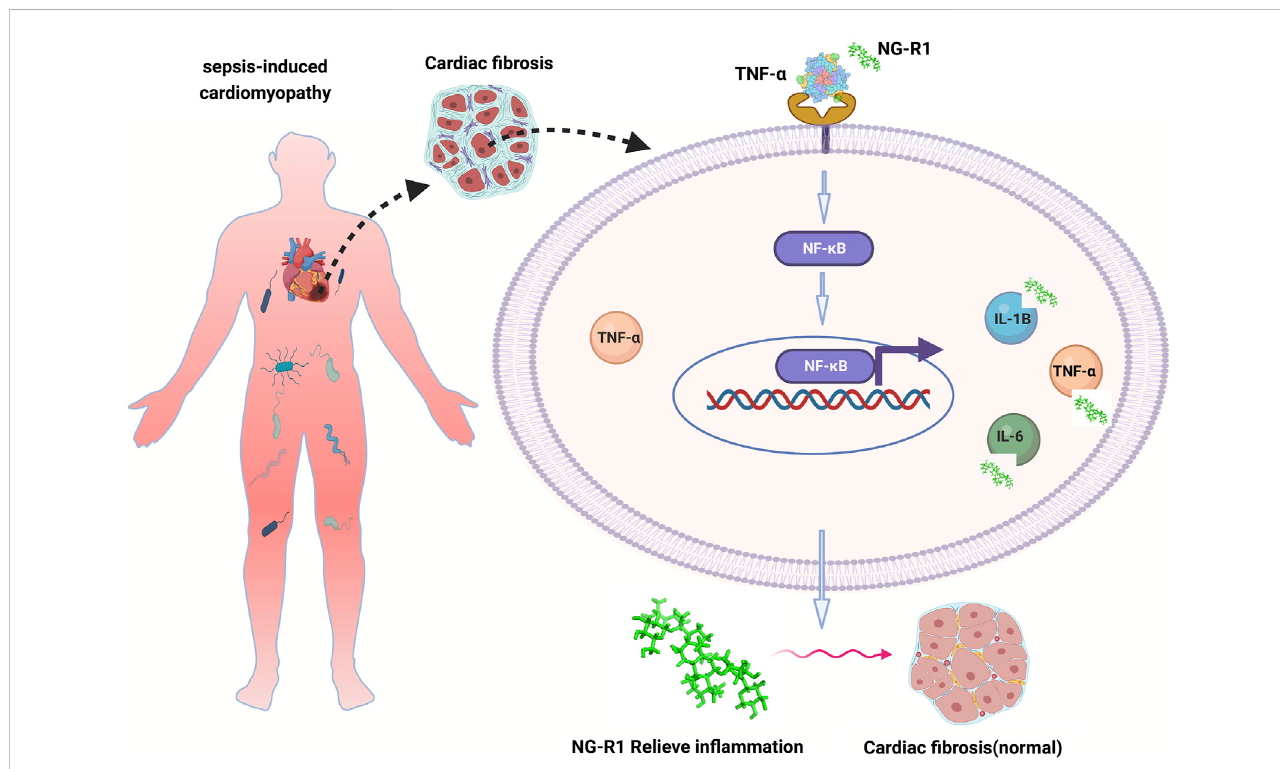
FIGURE 9 The mechanism of NG-R1 action on SIC is summarized in the fi gure. TNF- α is the core target of anti-in fl ammation in SIC, and NG-R1 may regulate the in fl ammatory response during myocardial injury in sepsis by regulating the expression of TNF- α , thereby reducing cardiac injury and cardiac